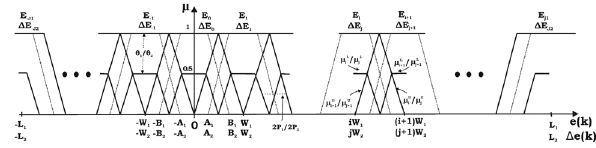
Fig. 12 Membership functions for multiple input fuzzy sets with 𝜃 1 = 𝜃 2 =